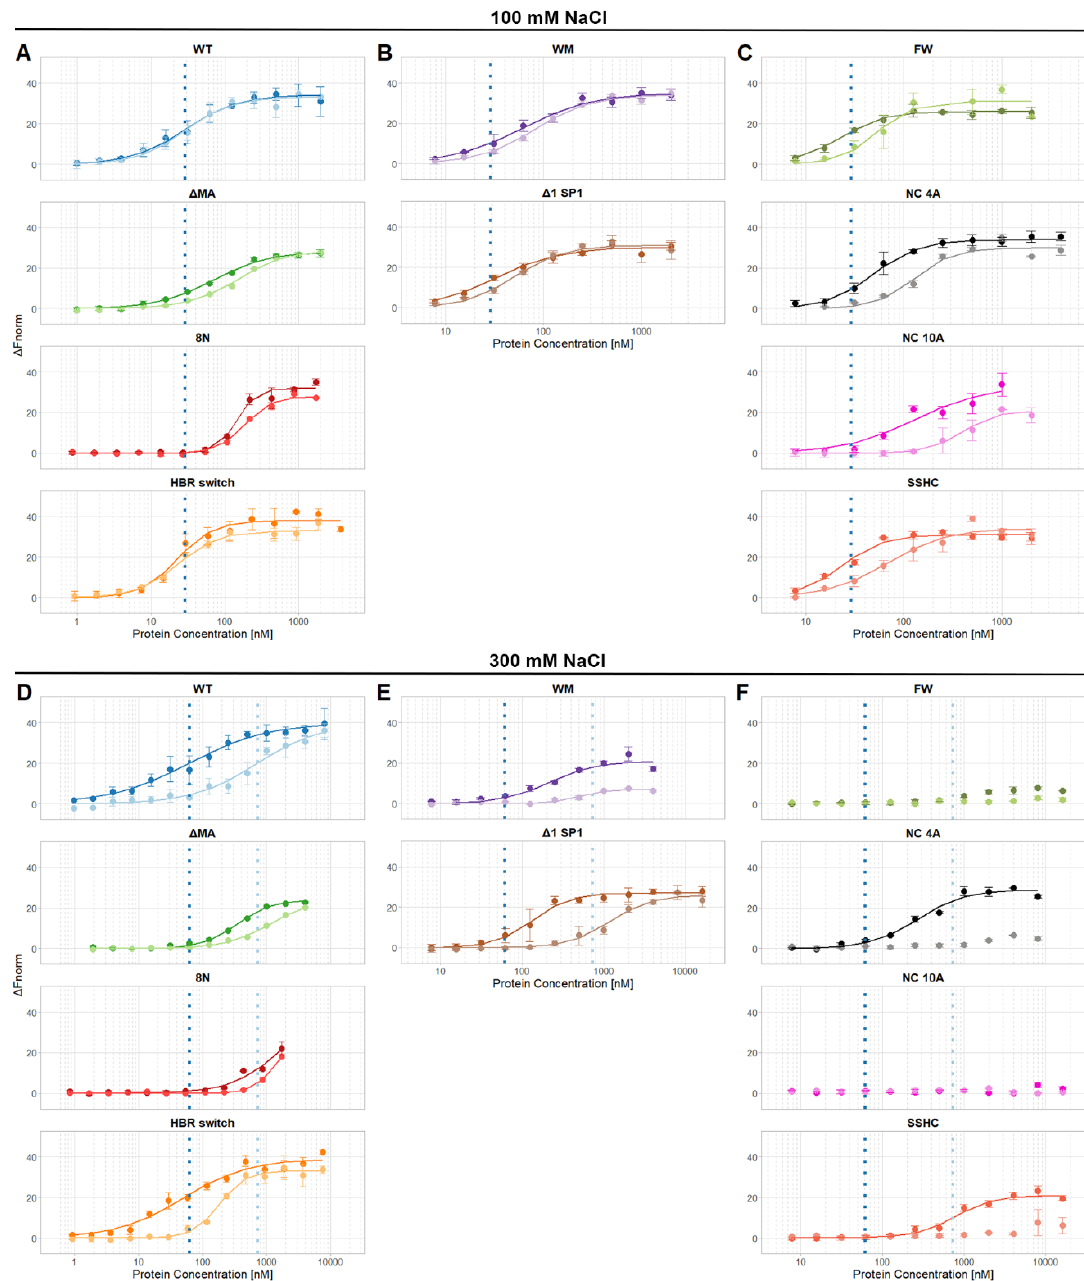
Figure 1. Binding curves of individual proteins. Panels ( A – C ) are binding curves obtained in bu ff er containing 100 mM NaCl; panels ( D – F ) are binding curves obtained in bu ff er containing 300 mM NaCl. Dashed vertical lines represent EC50 values of WT Gag with Ψ (dark blue) and reverse complement (light blue) RNAs. ( A , D ) WT and matrix mutants, ( B , E ) multimerization mutants, ( C , F ) nucleocapsid mutants. The p6 domain is not present in any of these proteins.